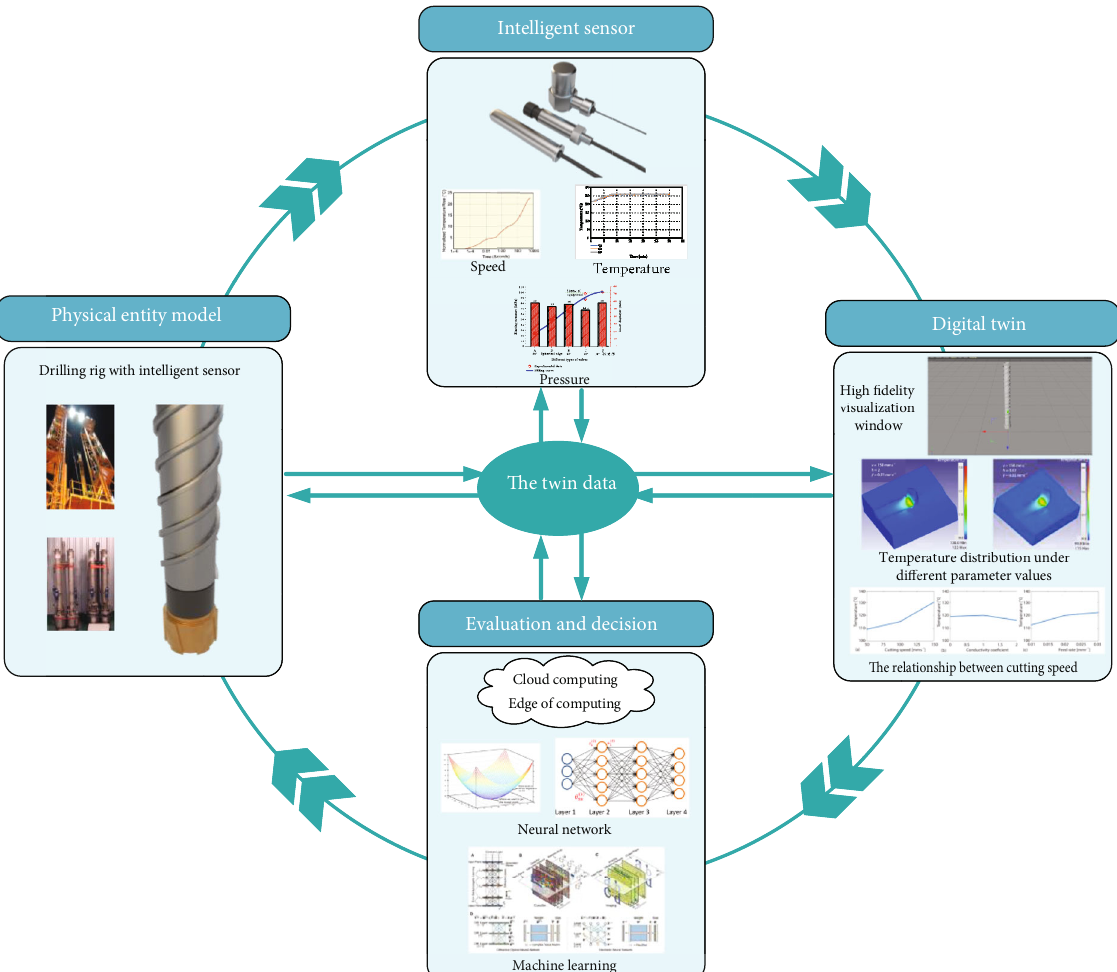
Figure 2: Schematic diagram of the digital twin